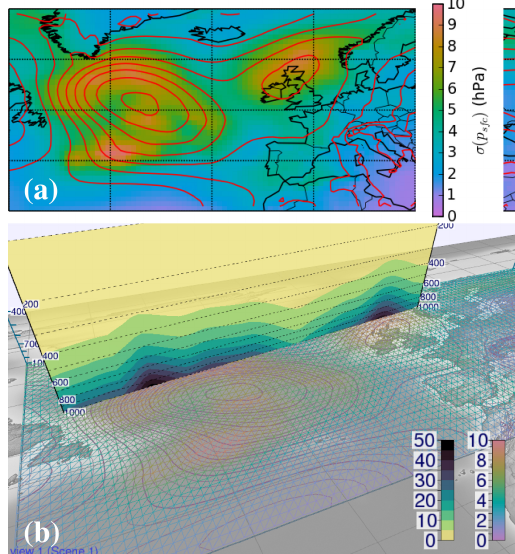
Figure 13. (a) SD of surface pressure, σ(p sfc ) . Forecast from 00:00UTC, 15 October 2012, valid at 18:00UTC, 19 October 2012. Red contour lines show mean sea level pressure. (b) Vertical sec- tion of the pressure difference (yellow-blue-black colour bar in hPa) between highest and lowest ensemble member, rendered on top of a wireframe map of σ(p sfc )